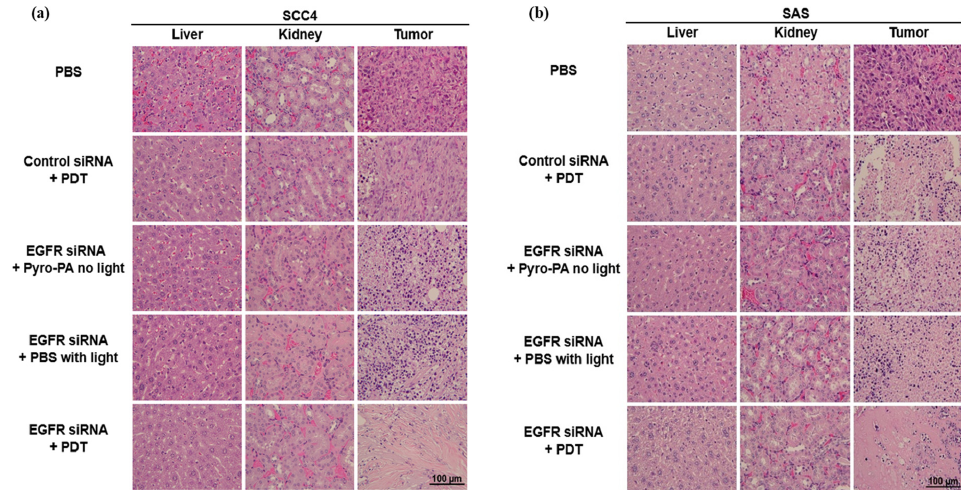
Figure 6. Hematoxylin and eosin staining of SCC4 and SAS Tumors. Hematoxylin and eosin histopathological stains of liver and kidney organs and SCC4 ( a ) and SAS tumors ( b ) of xenograft mice. Original magnification 40×. Scale bar stands for 100 µm.